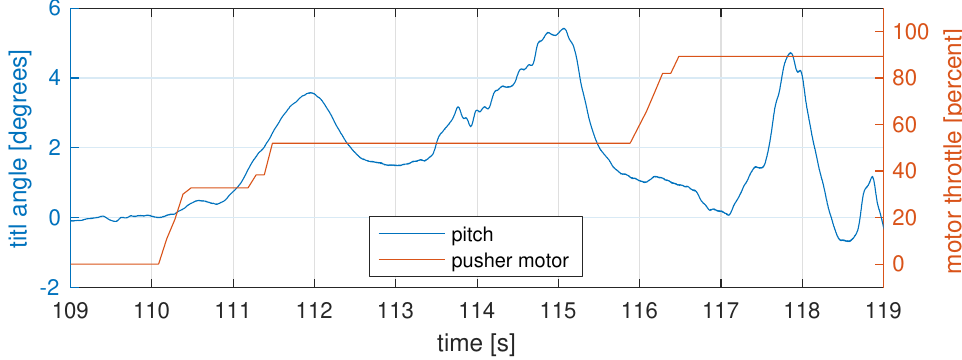
Figure 27. Telemetry log from an in-flight experiment: pitch instability in plane mode flight.